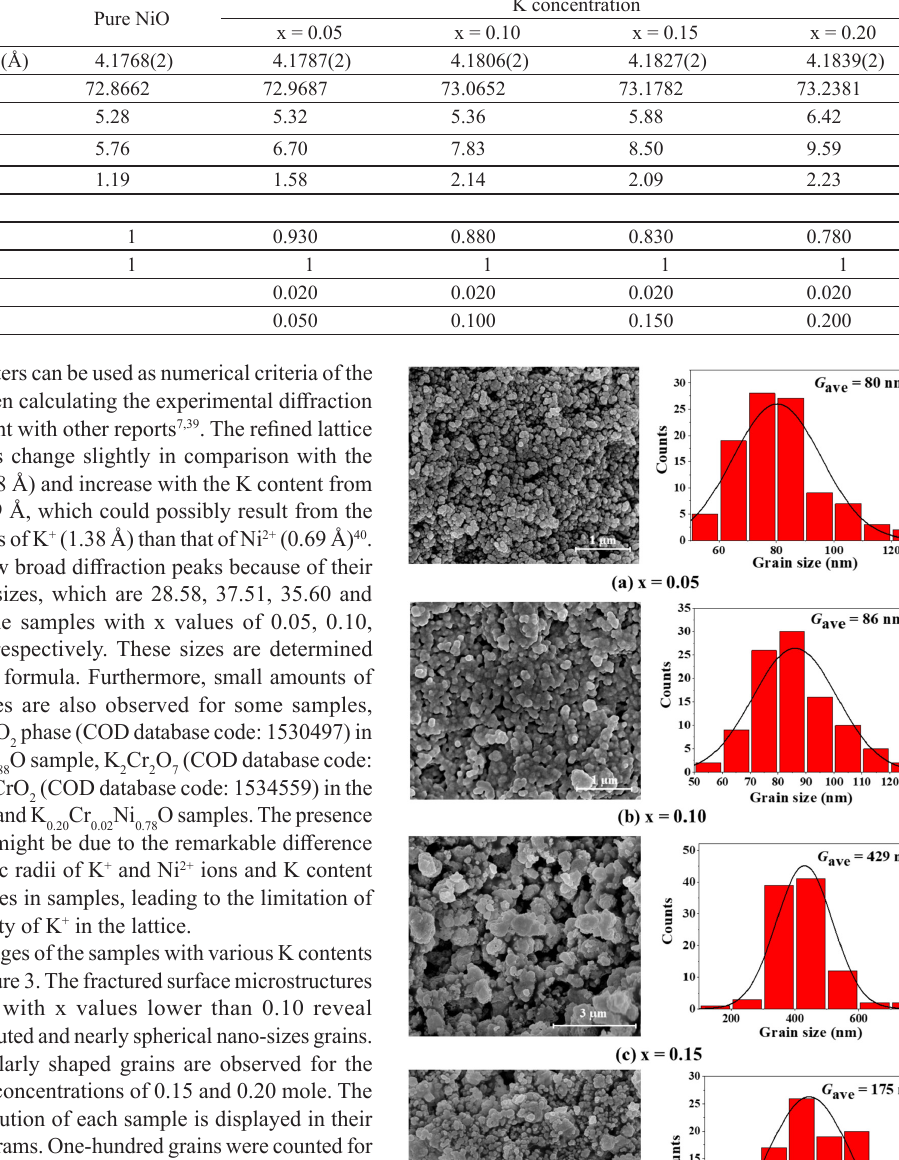
Cr Ni O samples with (a) x = 0.05, x 0.02 0.98-x